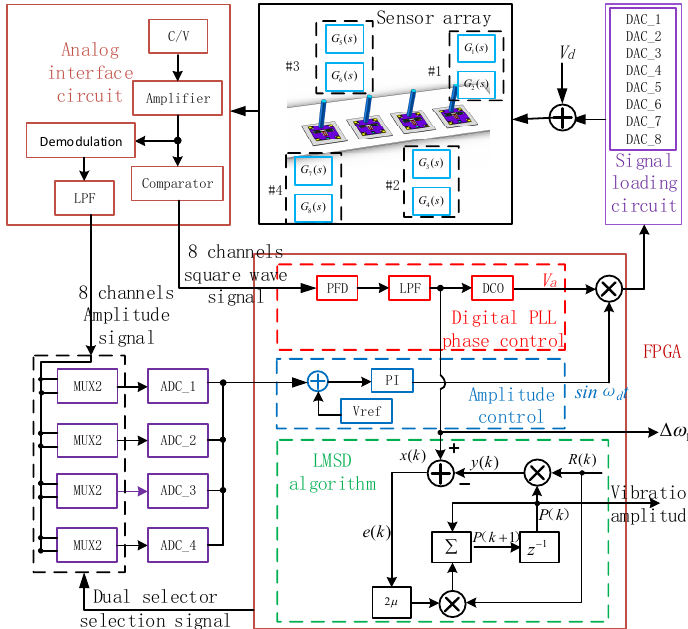
Figure 8. Measurement and control circuit block diagram of the system.